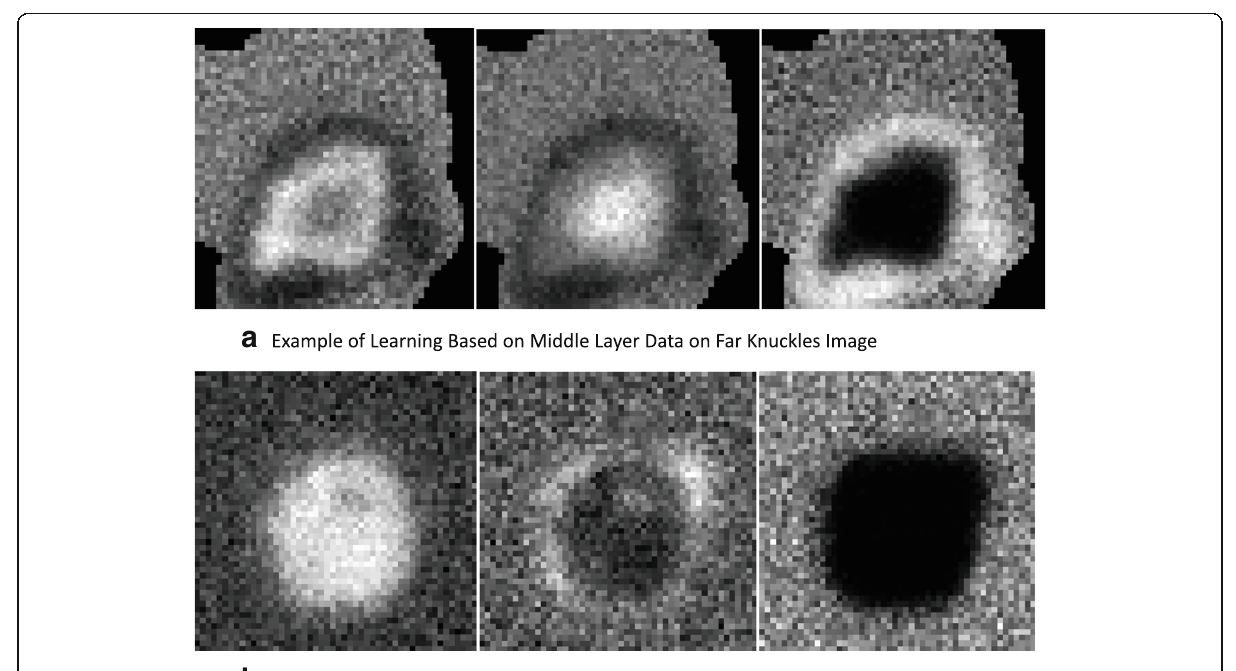
Fig. 7 Example of hidden label Gaussian process learning on middle-layer image data for knuckles. a Example of learning based on middle-layer data on far knuckles image. b Example of learning based on middle-layer data on middle-knuckle